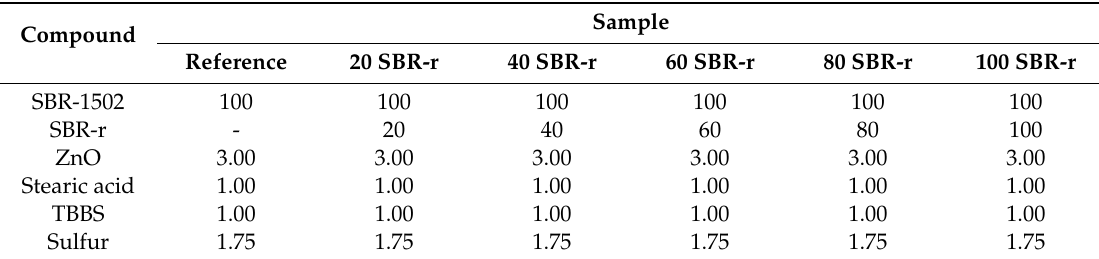
Table 1. Composites formulation, in parts per hundred of rubber